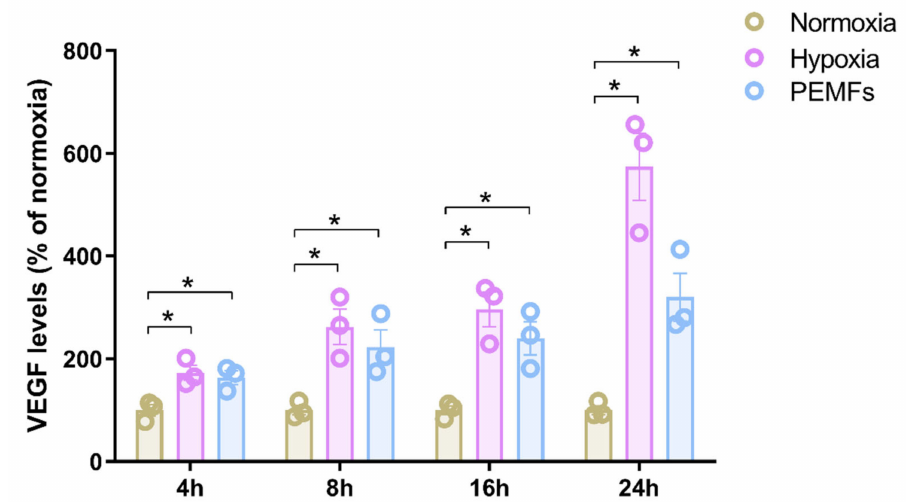
Figure 2. VEGF released by 1321N1 following normoxia, hypoxia or PEMF treatment in normoxia. 1321N1 cells were incubated from 4 to 24 h in normoxia in the absence or presence of PEMFs and hypoxic conditions. Supernatant was collected for the quantification of VEGF levels. Data are expressed as mean ± SEM of three independent experiments. *, p < 0.01 vs. normoxia at the same time